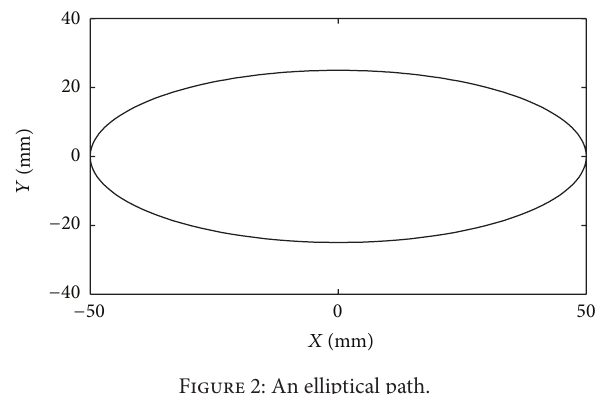
Figure 2: An elliptical